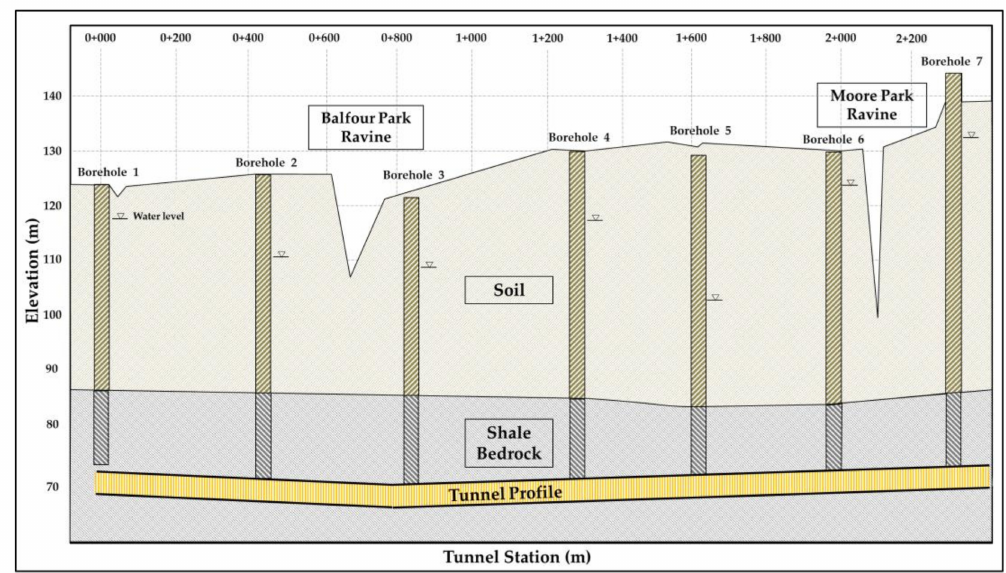
Figure 2. Proposed tunnel profile on simplified